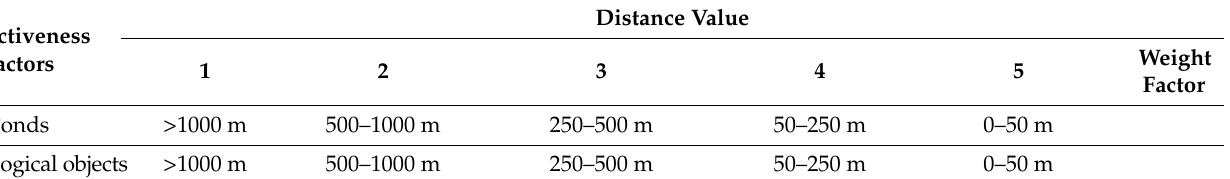
Table 2. Evaluation of